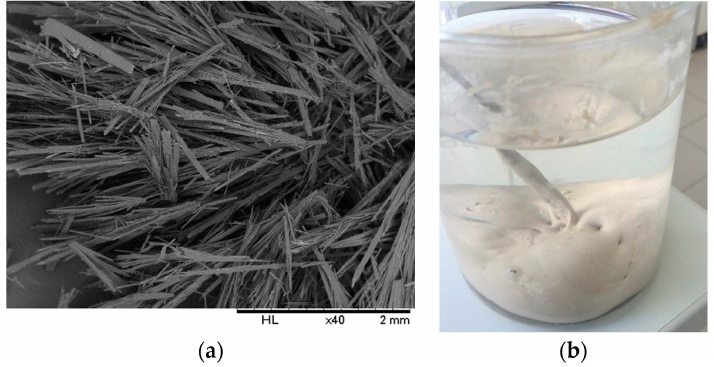
Figure 1. ( a ) SEM image of the azacrown polyether showing fibrous crystals after crystallization ( b ) a photograph of the synthesized azacrown ether precipitate in distilled water before